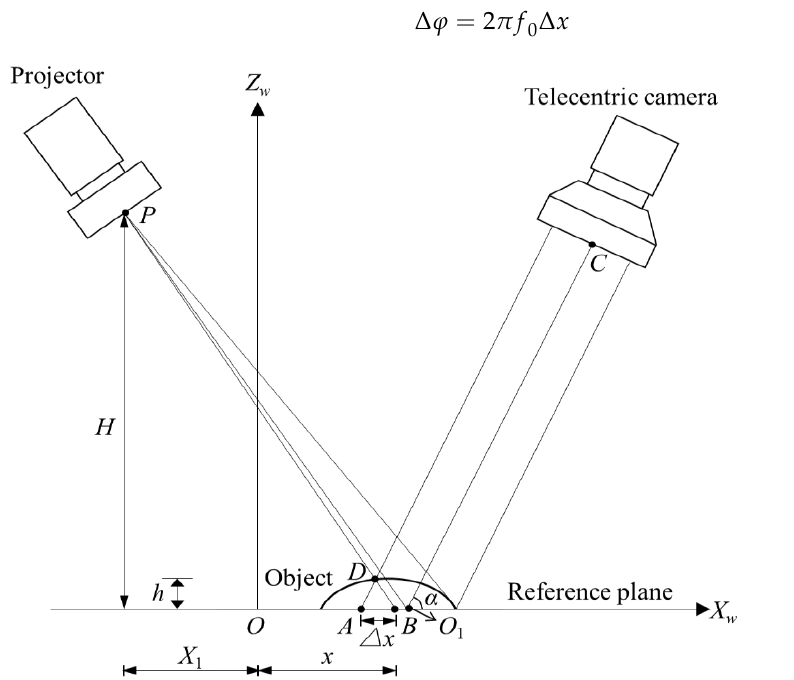
Figure 1. Imaging model of a telecentric fringe projection system.